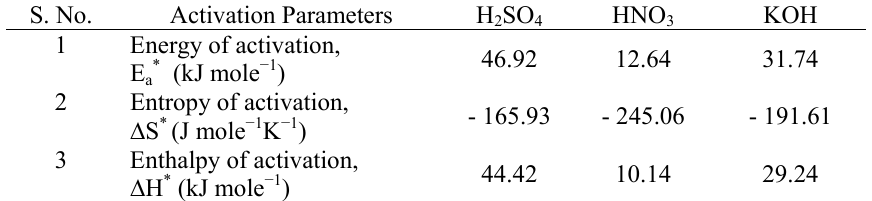
Table 4. Kinetics of corrosion of Iron: activation parameters S.